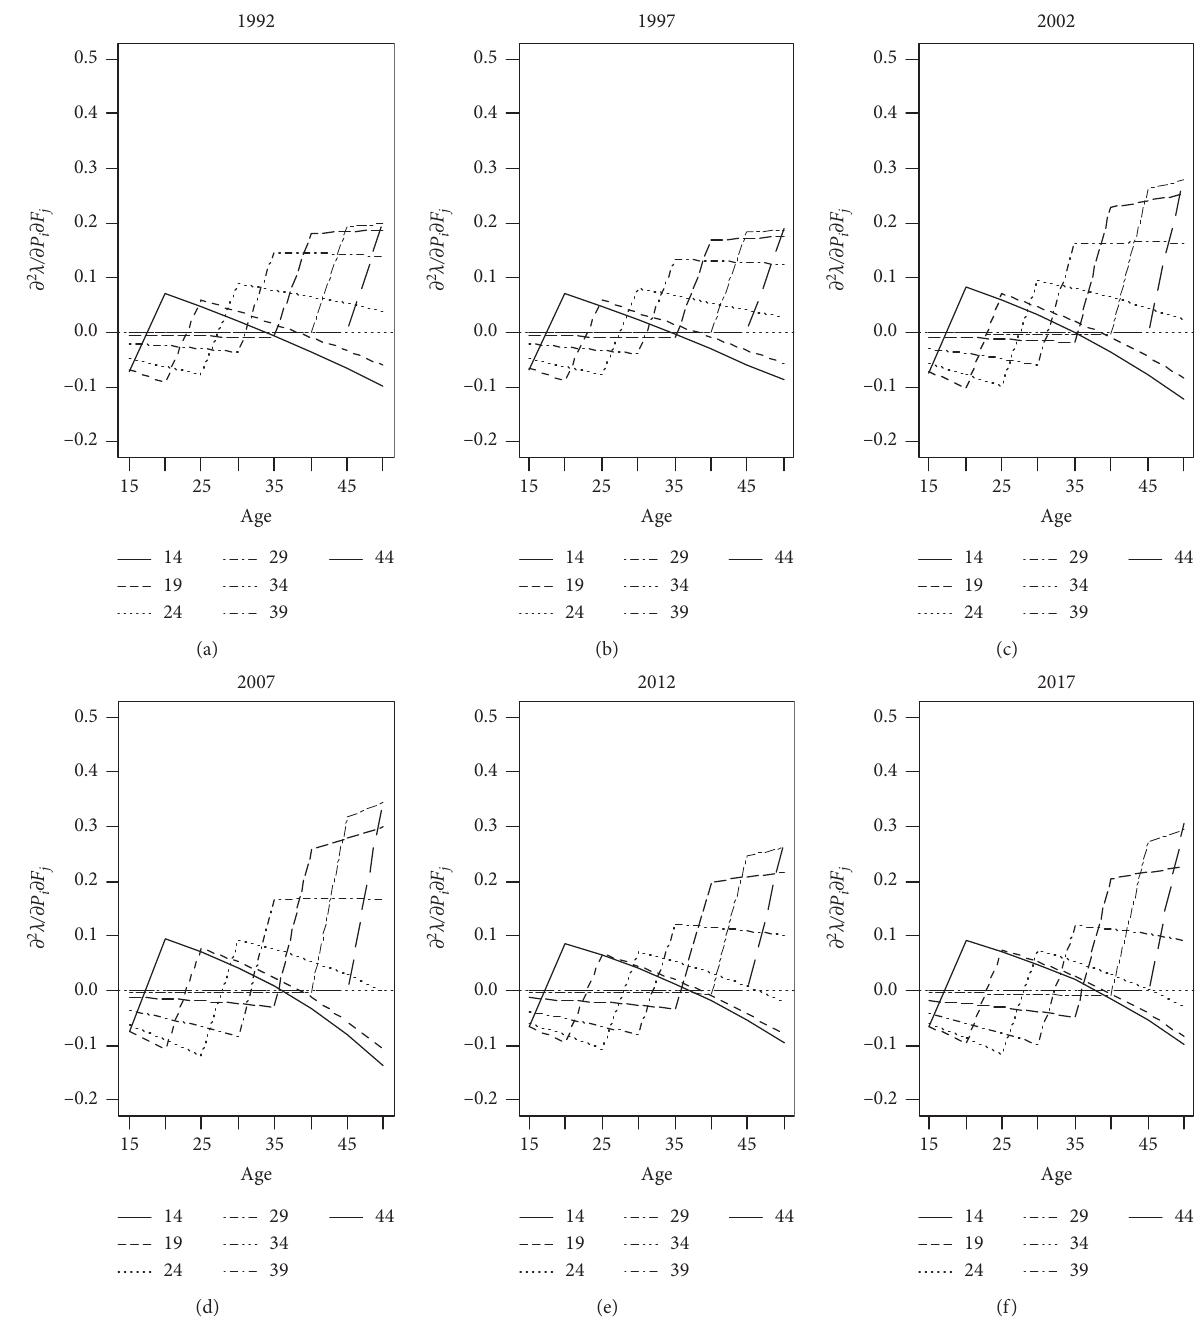
Figure 10: PGR second derivatives with respect to survival and